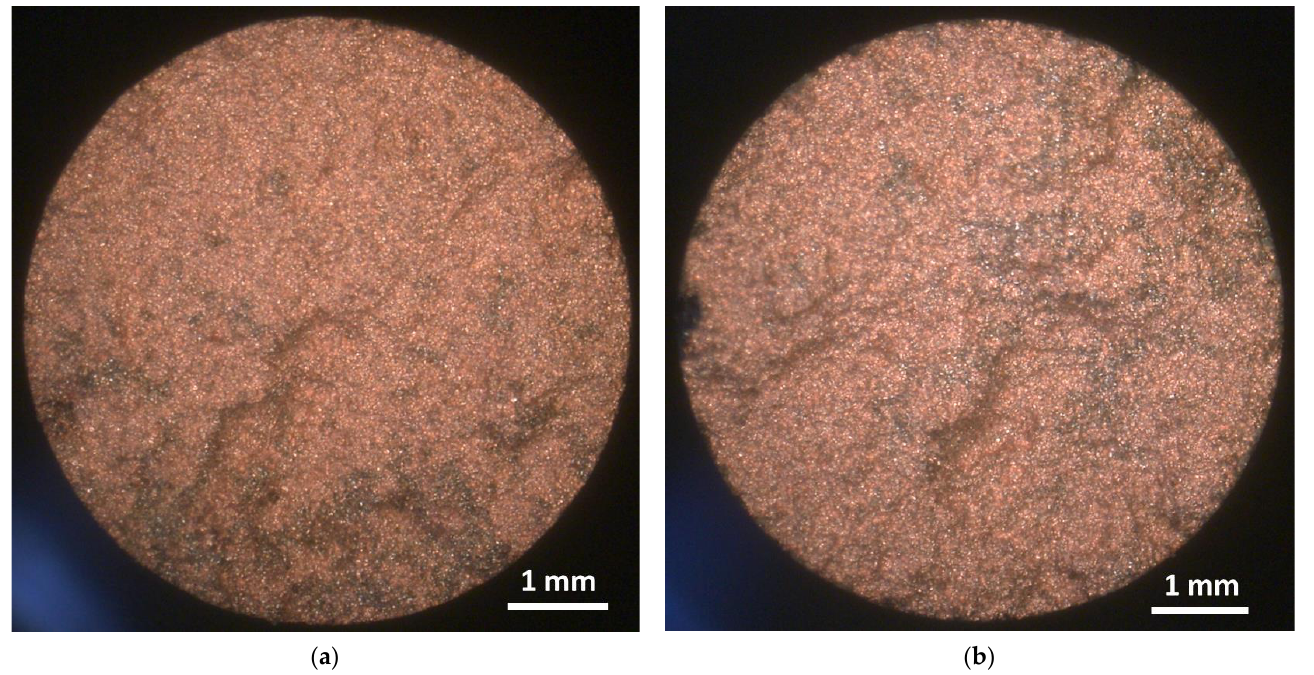
Figure 10 . Optical images of the fractured surfaces of H11/Cu tensile specimens containing ( a ) 59.4 vol.% H11 and 40.6 vol.% Cu and ( b ) 72.0 vol.% H11 and 28.0 vol.% Cu.